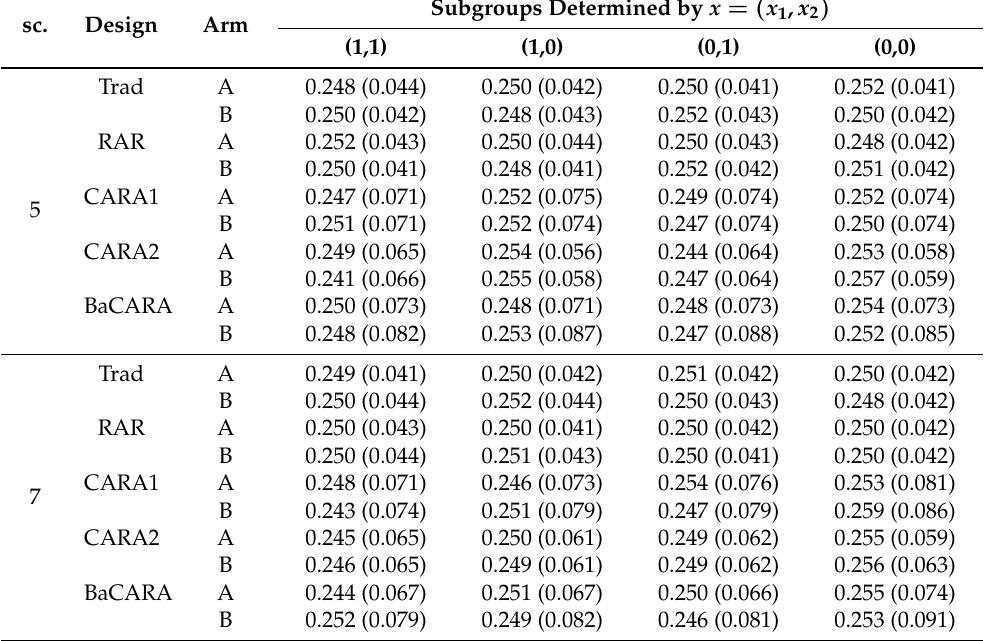
Table 3. Distribution of biomarker subgroups in each treatment arm under scenarios 5 and 7 for each design: mean (standard deviation) of the allocation probability of the treatment for each subgroup is reported. Note that “sc” denotes